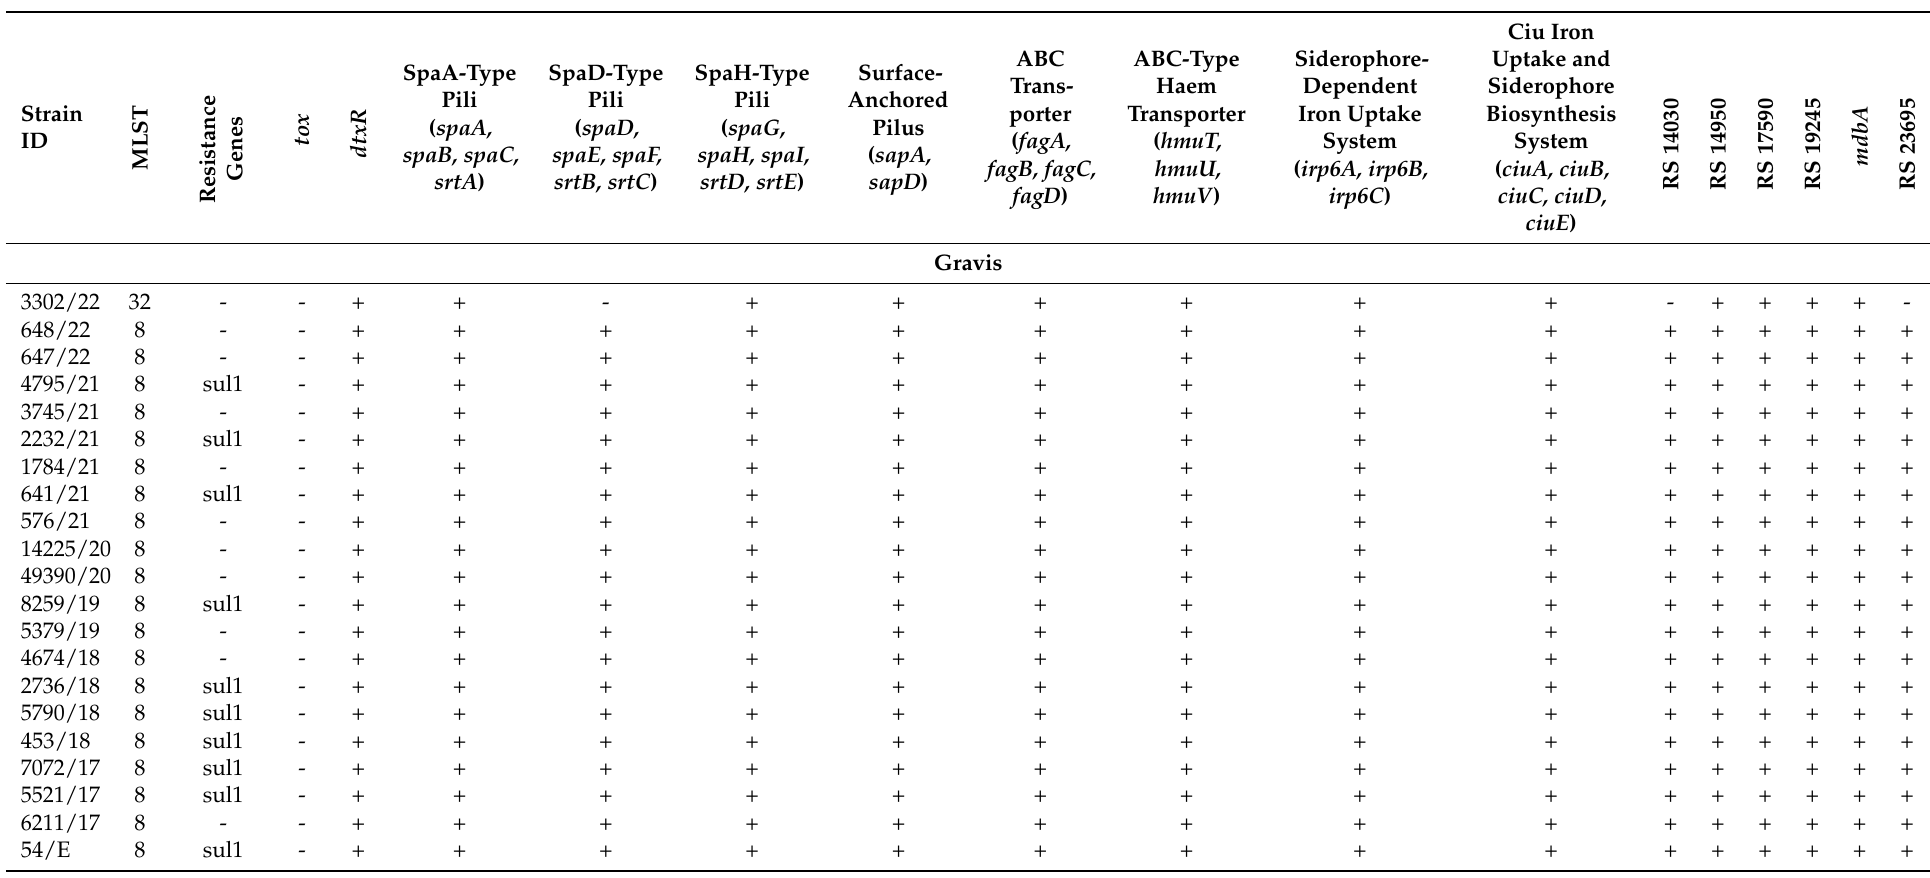
Table 2. The summary of the main results of the whole genome sequence analyses, including the 7-gene MLST typing, resistance gene profiles, and gene-encoded main C. diphtheriae virulence